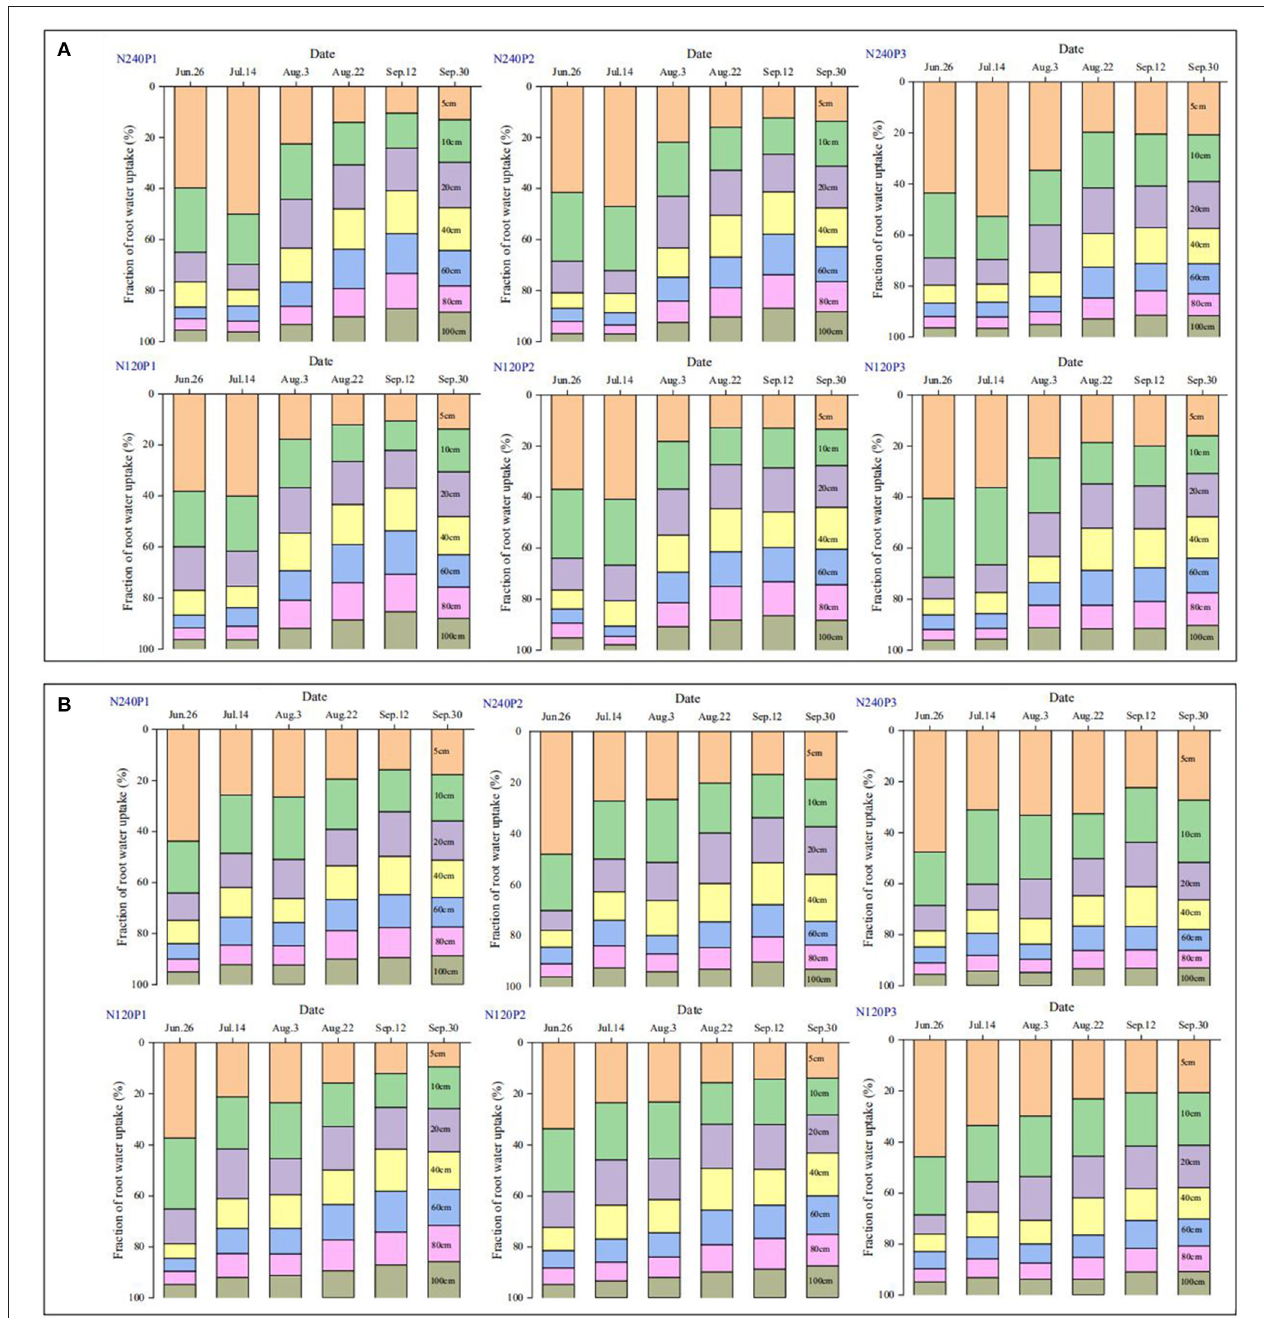
FIGURE 4 | Spatiotemporal changes in the normalized root water uptake rate under different treatments (see Figure 1A ) calculated based on the mass balance of isotopes and the Bayesian inference method; 2016 (A) , and 2017 (B) .